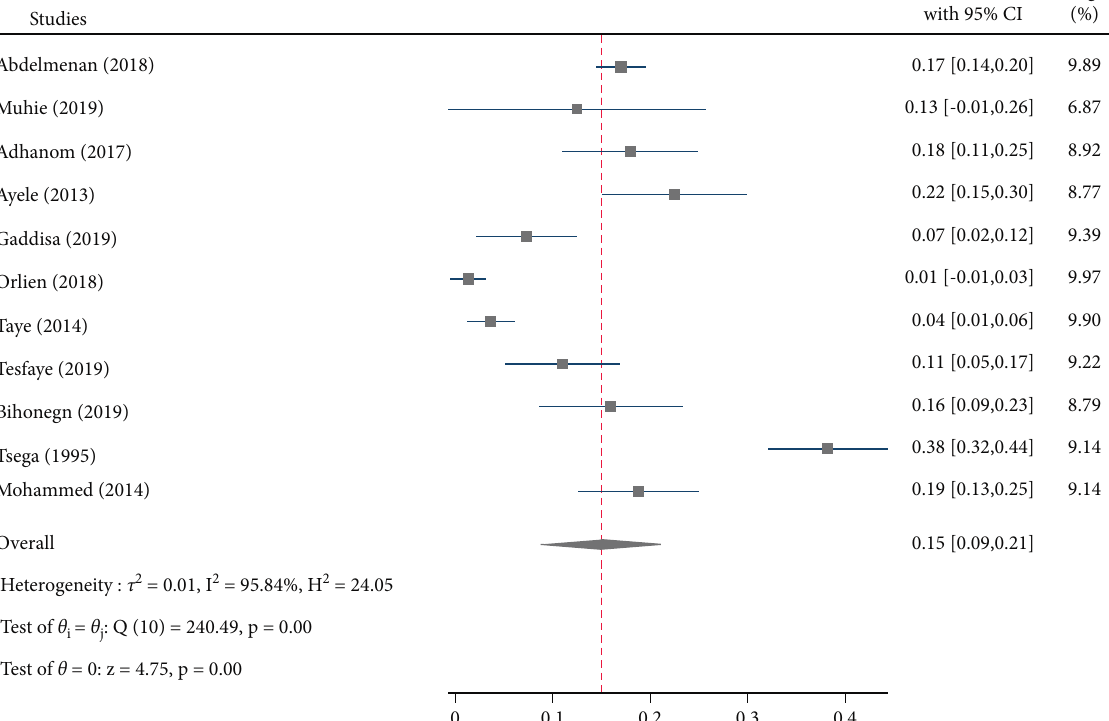
Heterogeneity : τ 2 = 0.01, I 2 = 95.84%, H 2 = 24.05 Test of θ i = θ j : Q (10) = 240.49, p = 0.00 Test of θ = 0: z = 4.75, p = 0.00